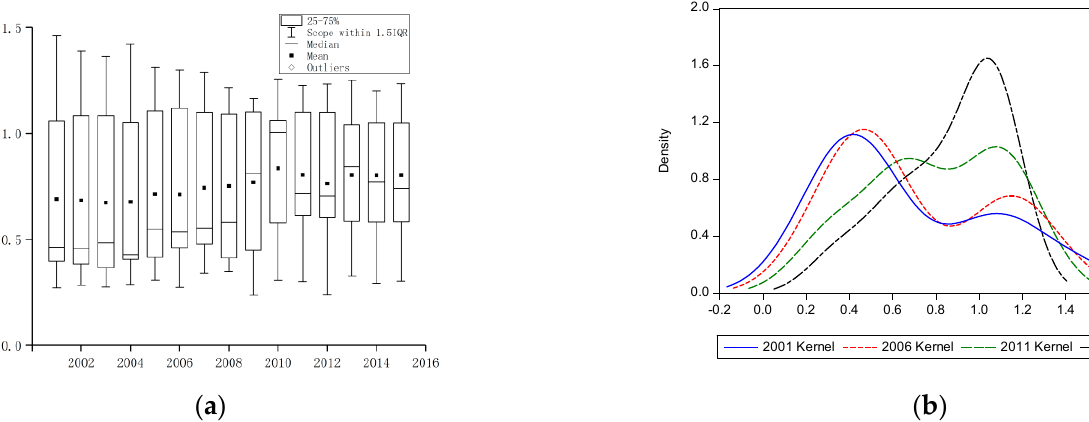
Figure 4. Box diagram( a ) and kernel density diagram( b ) of green development efficiency of the paper